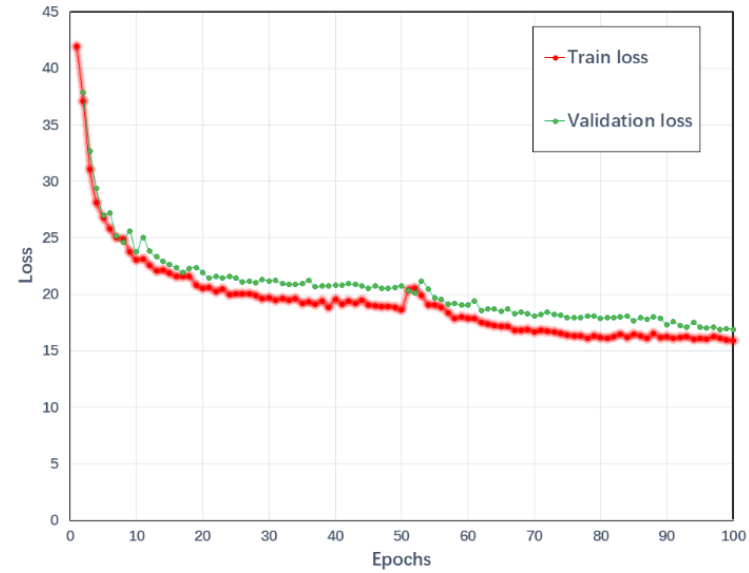
Figure 10. Model loss function